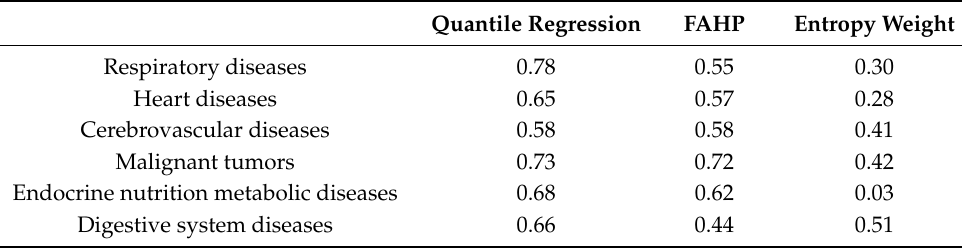
Table 2. Determination coefficients between vulnerability calculated by different weight determina- tion methods and corresponding disease